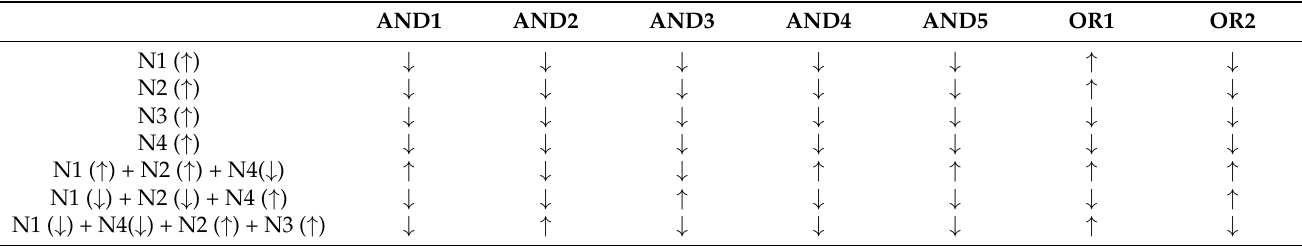
Figure 4 represents the modeled Synapse 1 (related to the food neuron) using a threshold (1 V)-dependent switch and a resistor. When the input is fed with a 5 V magnitude threshold (1 V)-dependent switch and a resistor. When the input is fed with a 5 V magni- signal, the SW1 switch turns on and provides 7 V to the output. The RF = 80 Ω is in a series tude signal, the SW1 switch turns on and provides 7 V to the output. The RF = 80 Ω is in a connection with SW1 to translate the input stimuli to the synapse output. series connection with SW1 to translate the input stimuli to the synapse output.